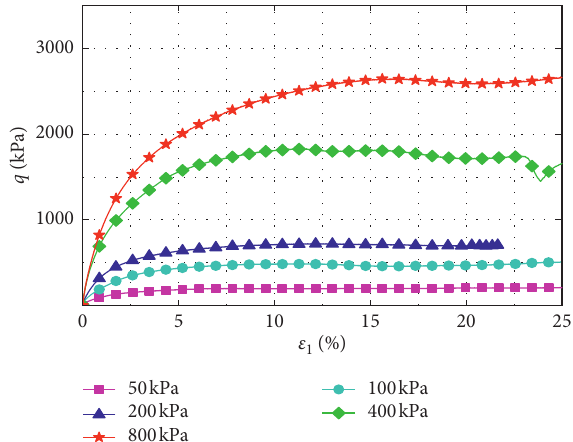
Figure 12: The relationships of q and ε